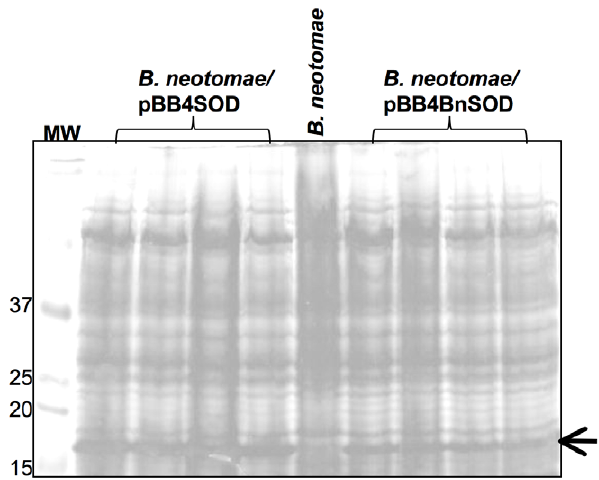
Figure 6. Detection of SOD overexpression in B. neotomae / pBB4SOD and B. neotomae /pBB4BnSOD by SDS-PAGE. Total antigens of the indicated bacteria were prepared from different individual recombinant colonies and loaded on each lane. The gels were stained with Coomassie brilliant blue G. The lane marked MW contain molecular weight markers and the numbers at the left indicate approximate molecular masses in kilodaltons. Arrow indicates the SOD protein.